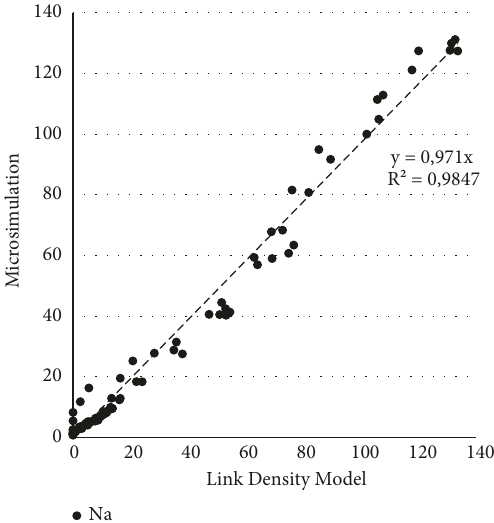
y = 0.9959x R² = 0.9767